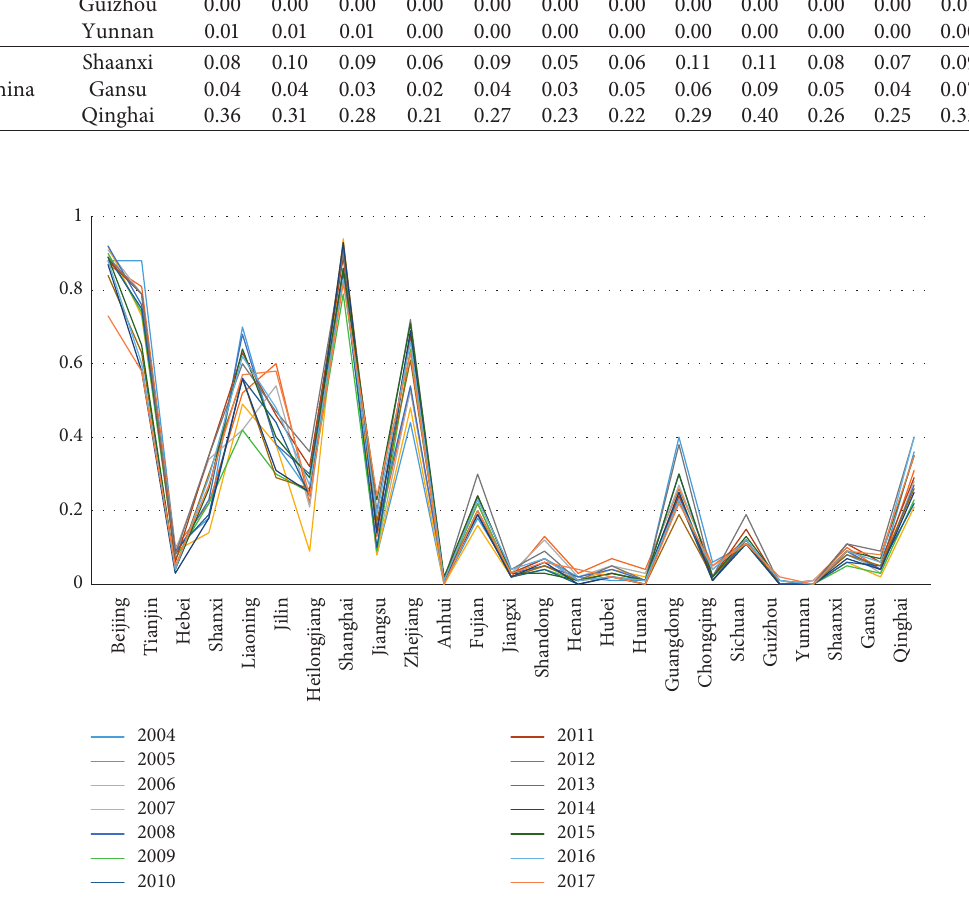
Figure 1: GFI of provinces and cities from 2004 through 2017.